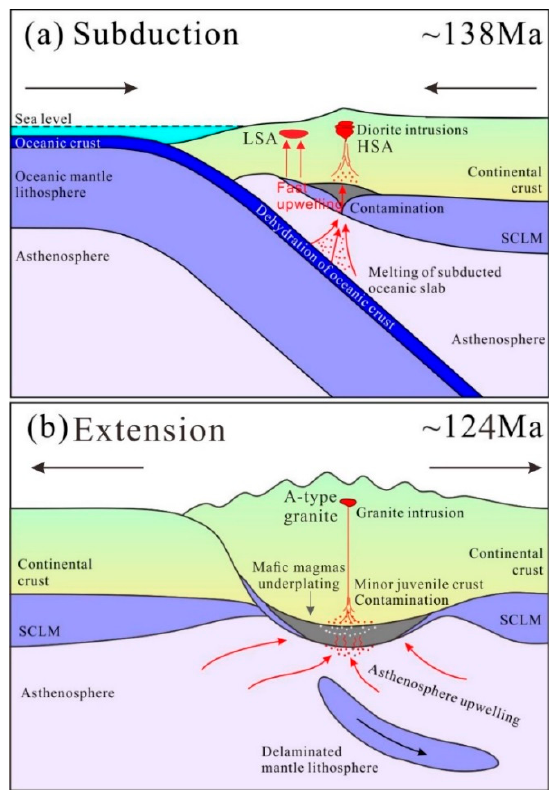
Figure 17. Schematic geodynamic model showing the petrogenesis of the Yueshan-Zongpu adakites and the Dalongshan A-type granites in the Anqing orefield during 138–124 Ma. ( a ) the subducted model revised from [10]; ( b ) the delamination model modified from [3]. See text for discussion. SCLM, subcontinental lithospheric mantle.